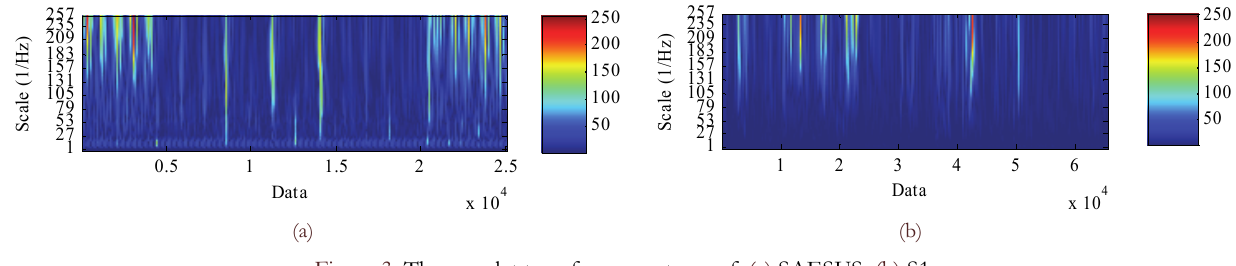
Figure 3: The wavelet transform spectrum of; (a) SAESUS, (b) S1.